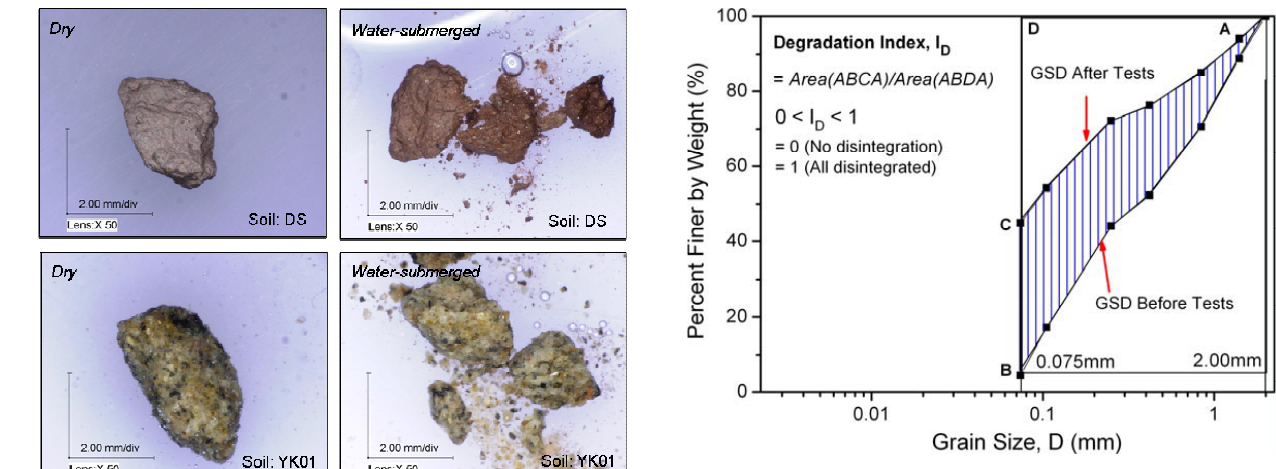
Fig. 7. Definition of degradation index, I D (after Hardin, 1985). Figure 7. Definition of degradation index, I D (after Hardin, 1985). 3